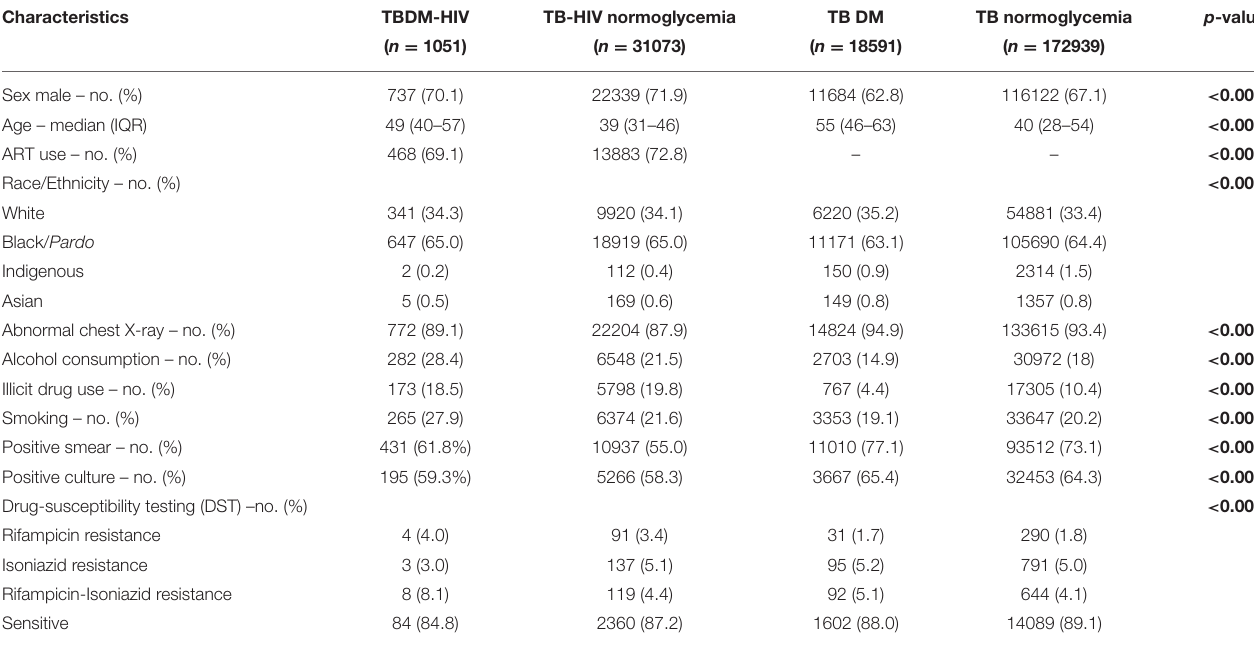
TABLE 2 | Characteristics of TB cases by DM and HIV status in SINAN